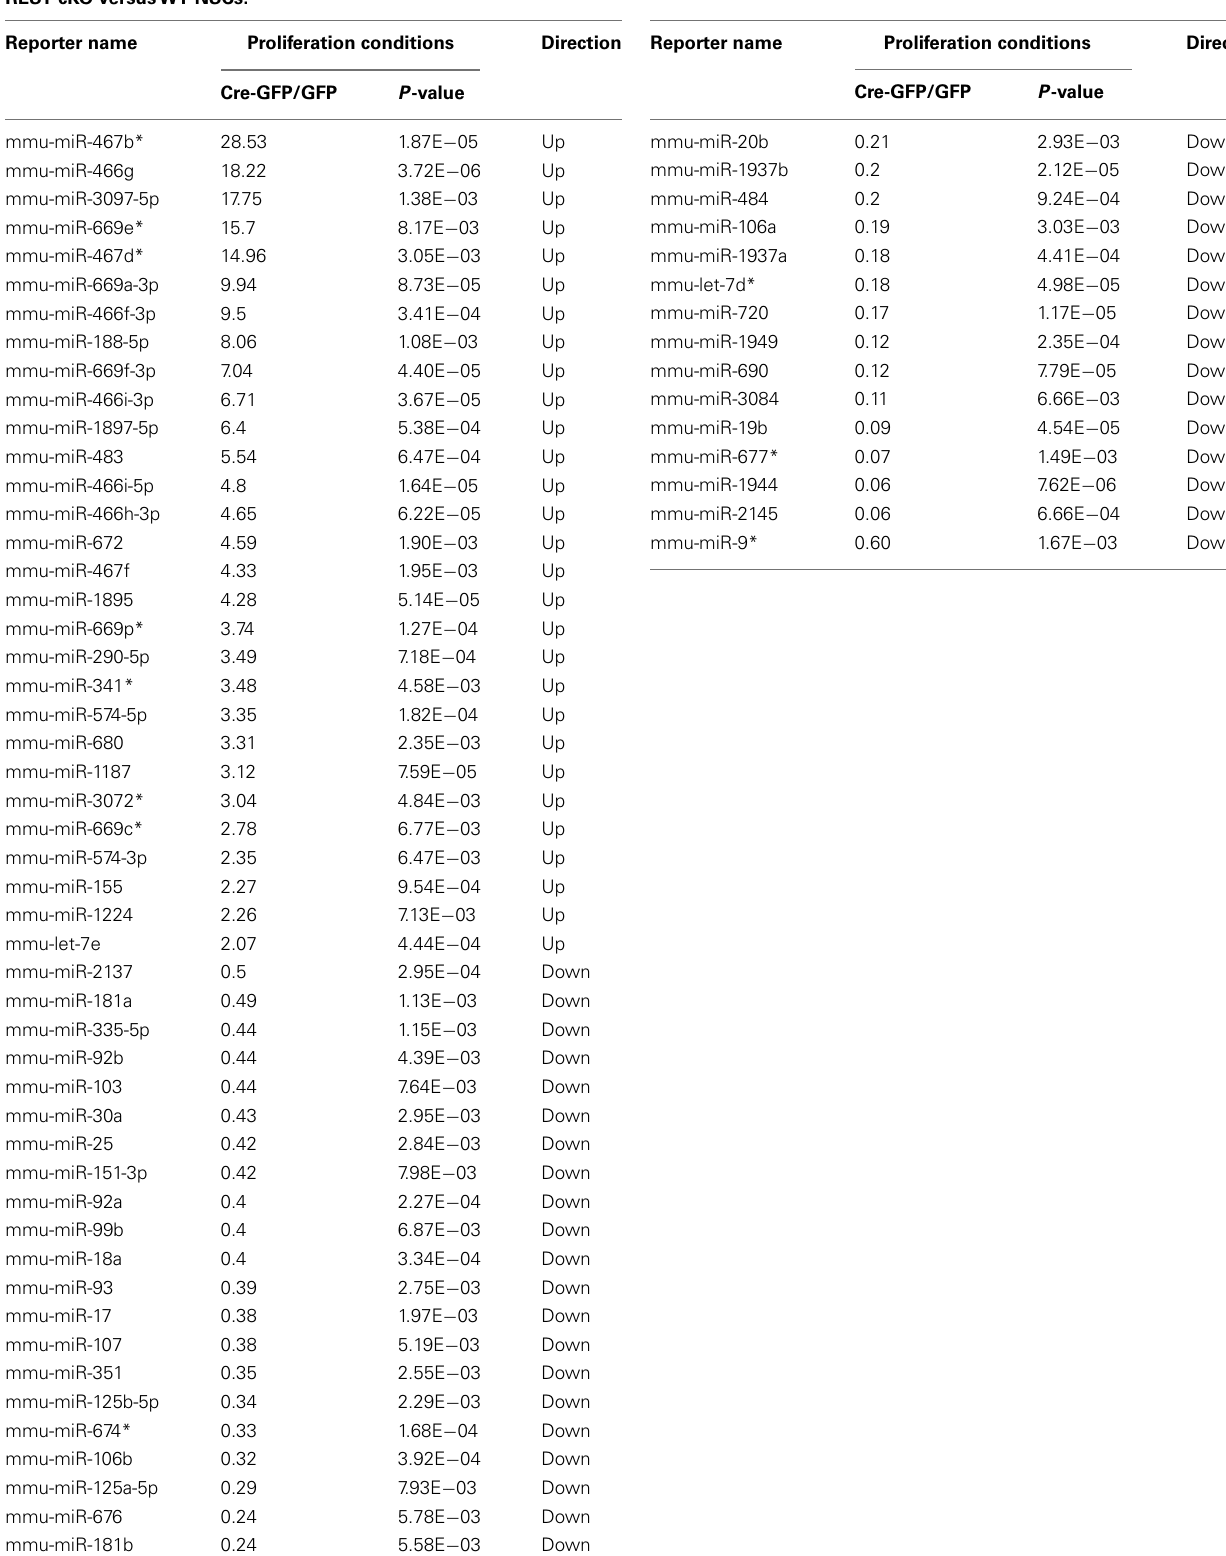
TableA4 | List of miRNAs that are significantly altered ( p < 0.01) in REST cKO versusWT